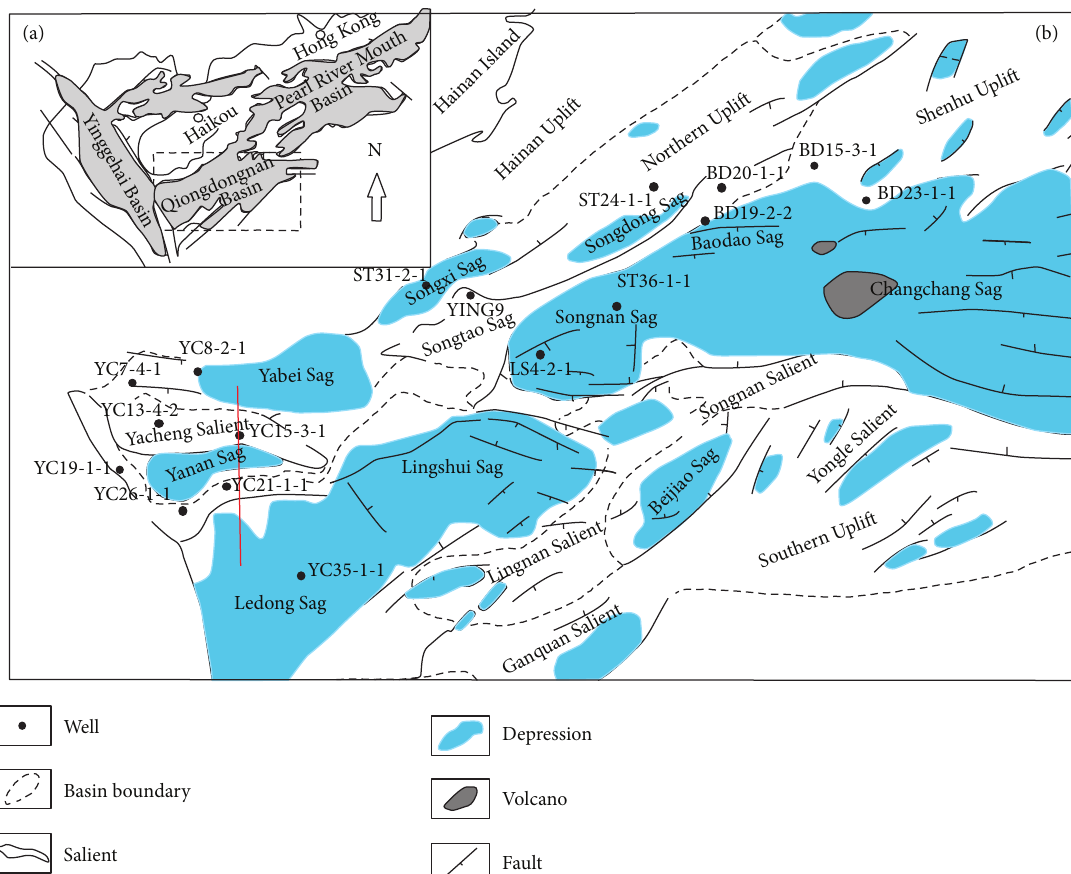
Figure 1: (a) The structural location of the Qiongdongnan Basin [46], northern South China Sea. (b) Geologic map showing the distribution of structural belts in the Qiongdongnan Basin. Table 1: Basic organic geochemical parameters for the Miocene marine source rocks in the Qiongdongnan Basin. TOC, % 𝑆 1 + 𝑆 2 , mg/g 𝐼 Formation Min. Max. Ave. Min. Max. Ave. Min. Max. Ave. Min. Max. Ave. N h 0.20 1 1.81 0.45 0.12 6.23 0.69 331 401 465